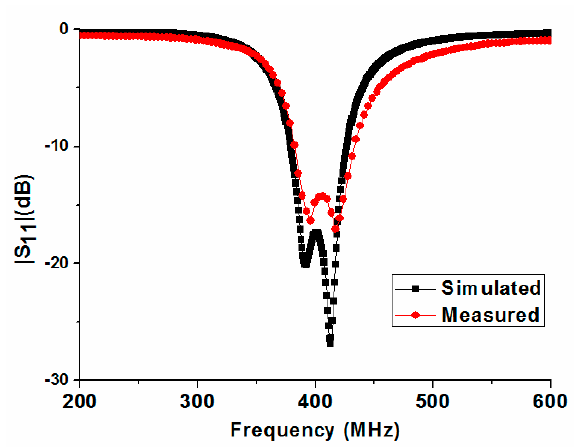
Figure 6. Measured and simulated | S 11 | of the proposed implantable antenna.